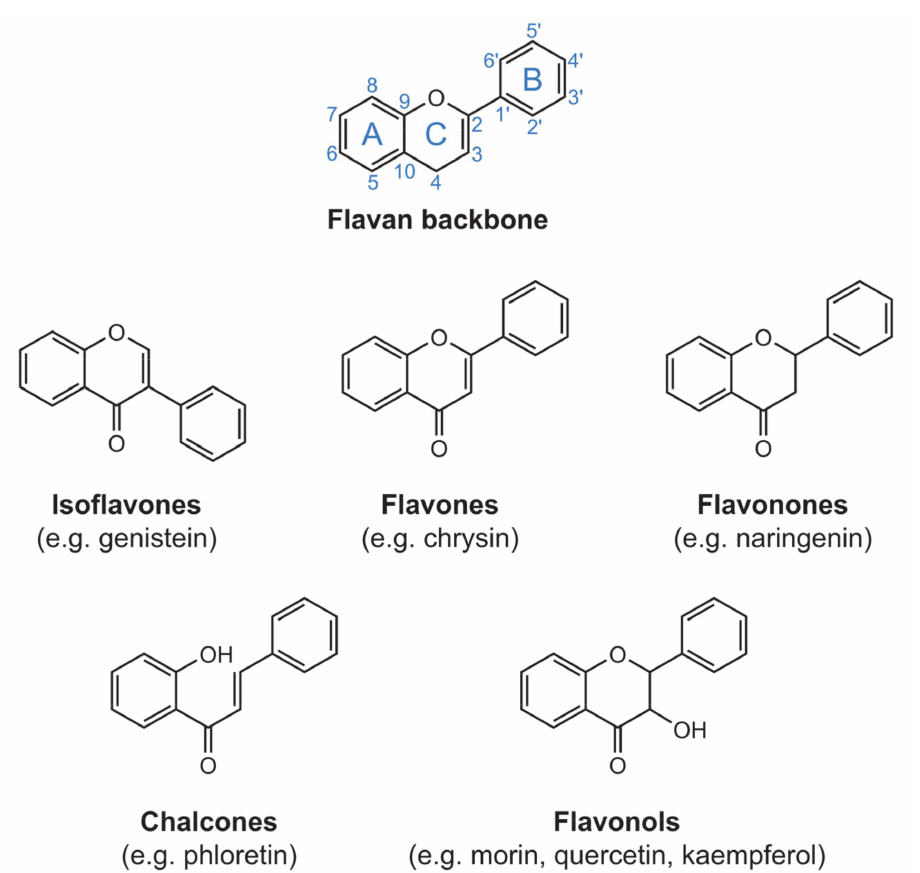
Figure 1. Structural representation of the flavan backbone, depicting the typical ring labeling scheme, and of the families of flavonoids of interest to the present review. Examples of compounds belonging to each family are given below the family